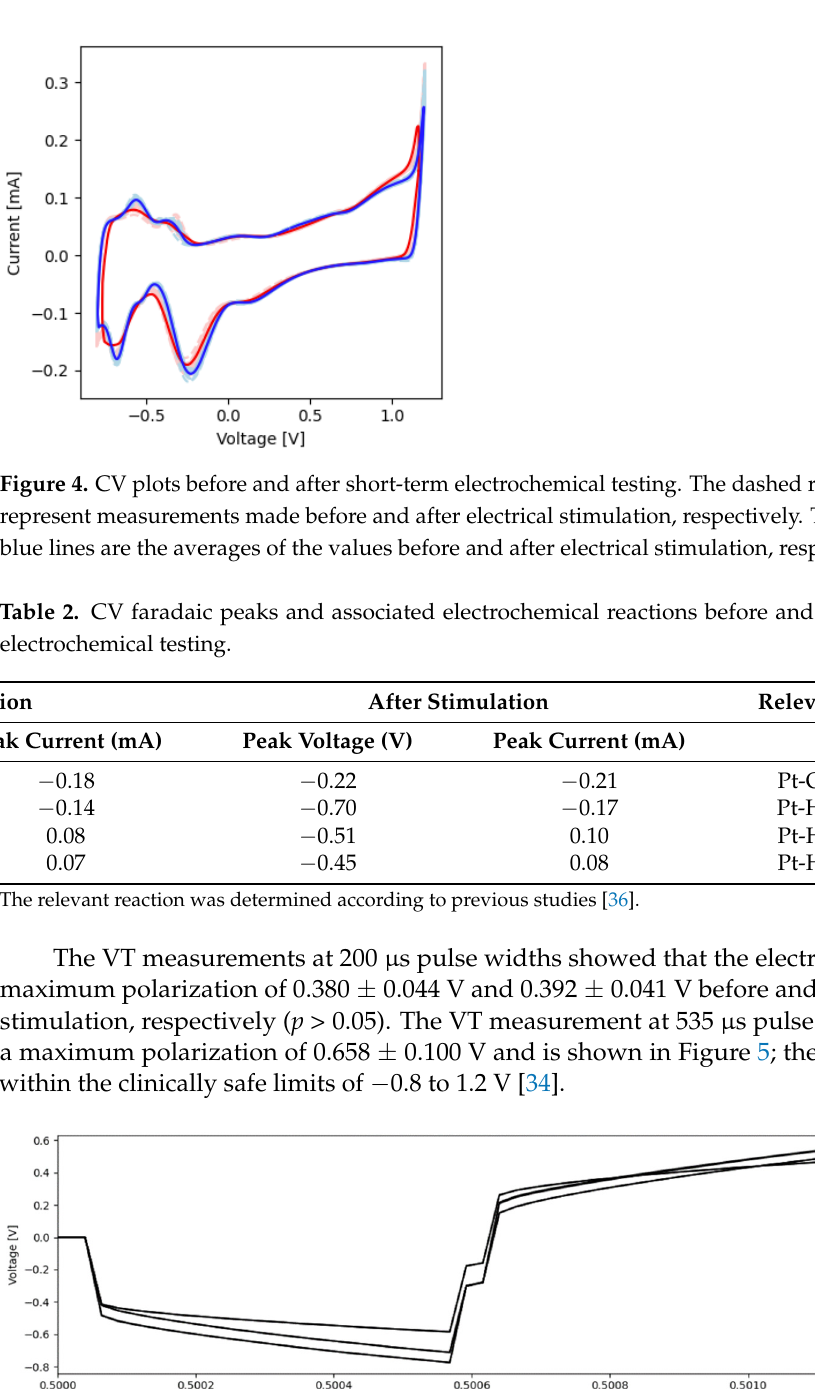
Table 1. EIS measurements before and after short-term test.